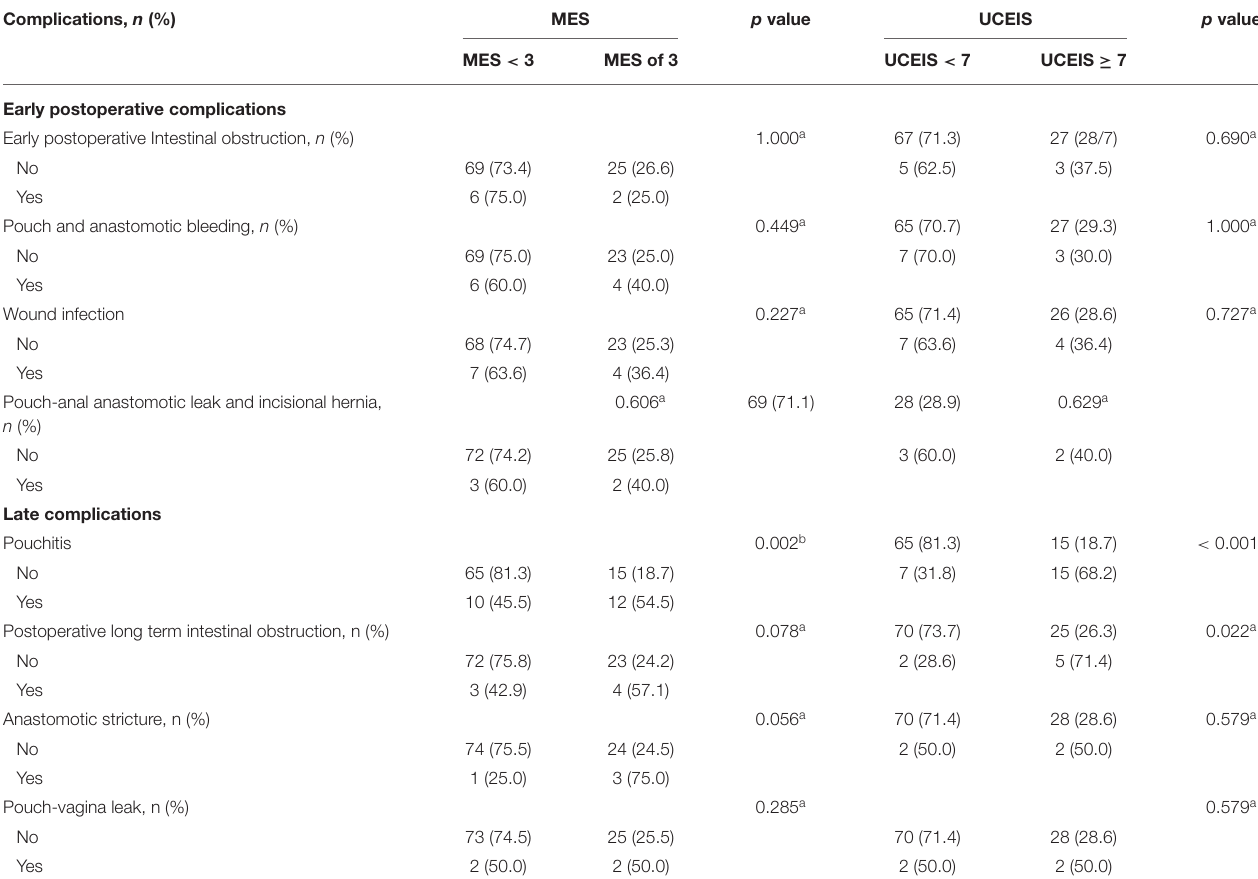
TABLE 3 | Analysis post-IPAA complications in differernt MES and UCEIS scores. Complications, n